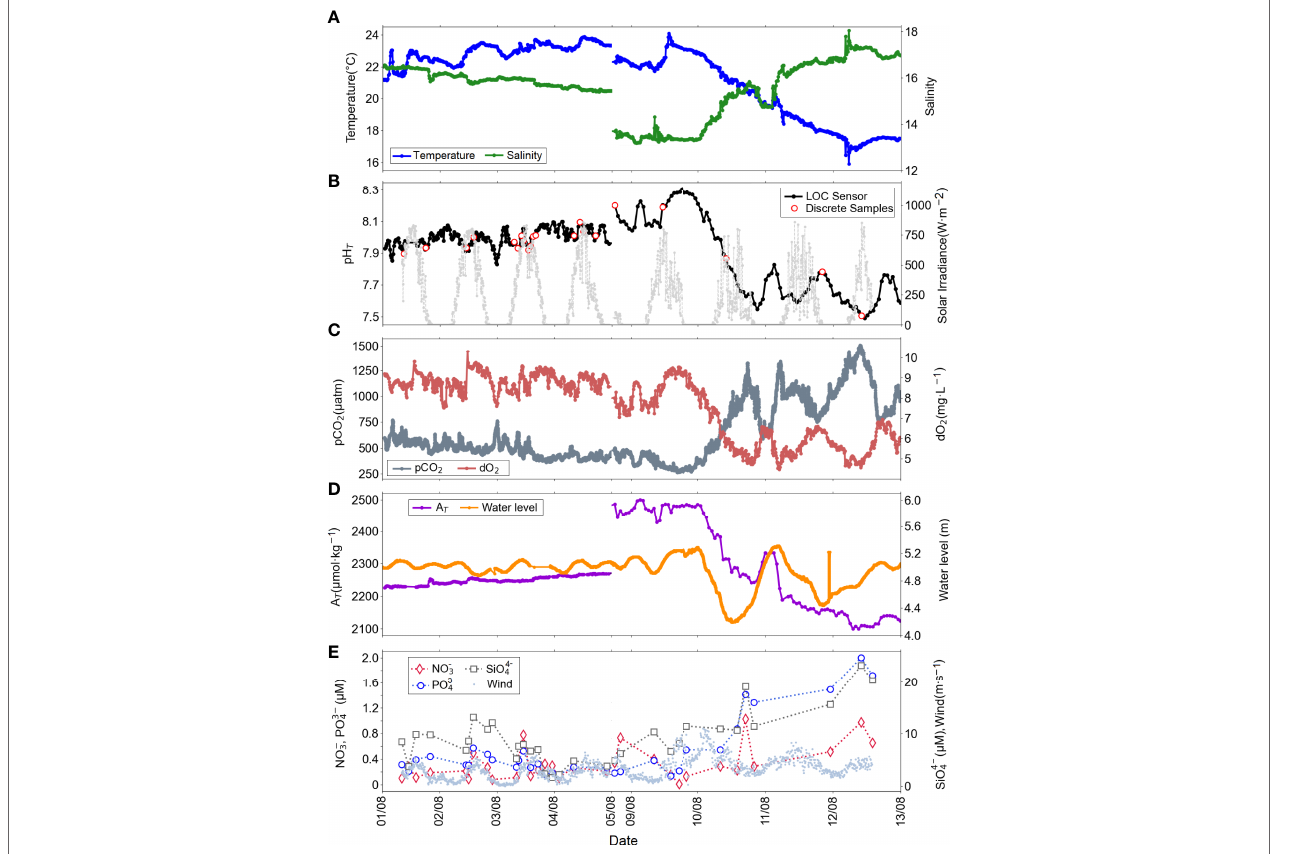
FIGURE 4 | Diel variations of (A) in situ temperature (blue), in situ salinity (green), (B) in situ pH T (black: LOC sensor, red circles: discrete water samples , yellow circle: outliers), solar irradiance (light grey), (C) in situ pCO 2 (dark grey), in situ dO 2 (coral), (D) salinity-derived A T (purple), water height (orange), and (E) NO 3- (red diamond), PO 43- , (blue circles), SiO 4-4 (grey squares), and wind speed (pale blue dots) with multiple sensors deployed at the GEOMAR pontoon in Kiel Fjord in summer 2018, from 01.08 to 05.08 and from 08.08 to